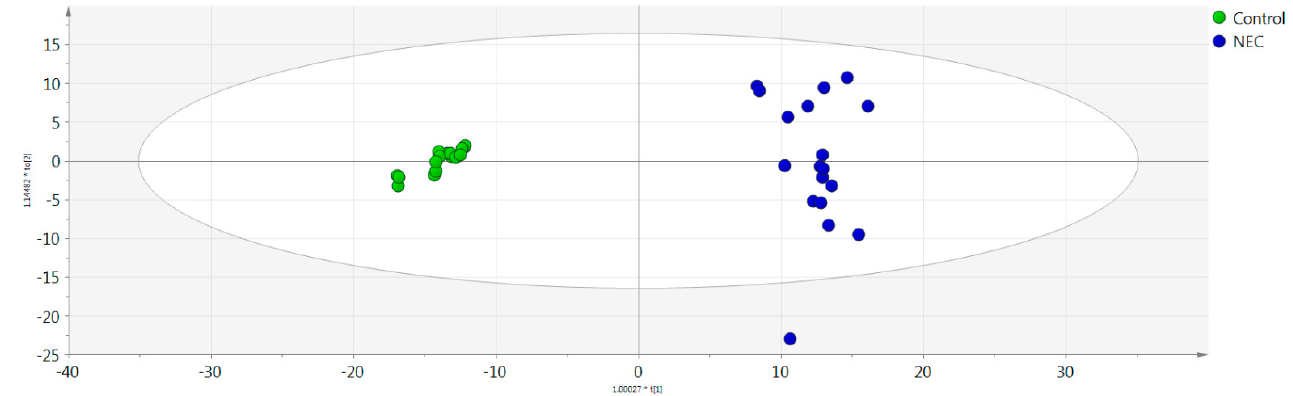
Figure 3. Orthogonal partial least squares discriminant analysis (OPLS-DA) score plots of the control and necrotizing enterocolitis (NEC) groups. Y and X axes represent [t2] and [t1], respectively. Table 2. Statistically significant features with their respective q-value (Bonferroni), p(corr), and VIP values.